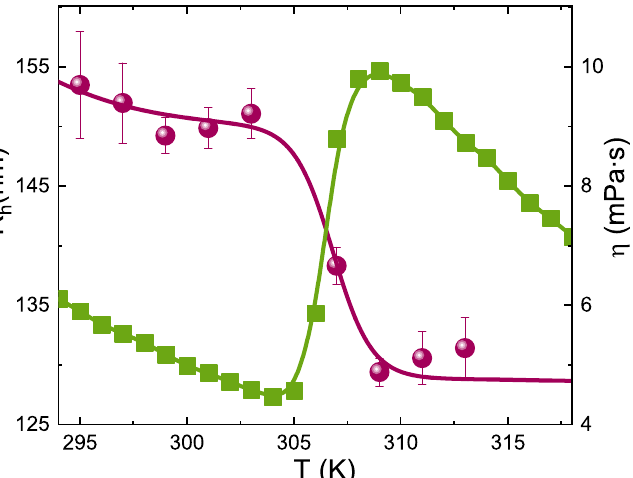
Figure 1. Hydrodynamic radius R h (left axis, circles) for IPN microgel at C PAAc = 24.6% as a function of temperature measured in diluite conditions ( C w = 0.01%) compared with the viscosity (right axis, squares) at concentration C w = 0.3% and shear rate 10 s − 1